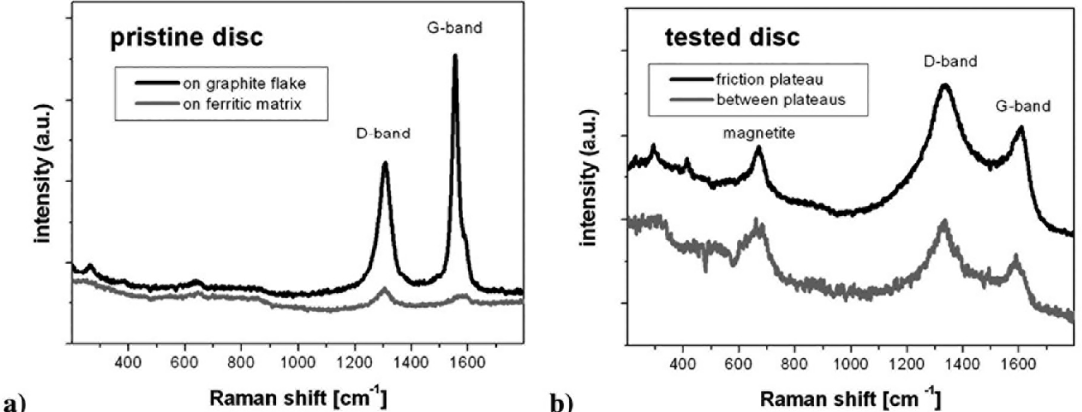
Figure 2. Micro-Raman spectra a) from graphite flakes of the pristine disc; b) after the AK-master test. Magnetite and graphite G and D bands are indicated.